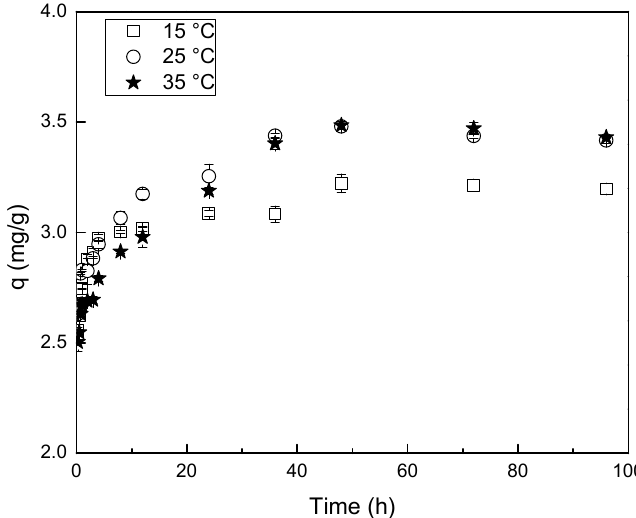
Figure 9. Impact of temperature and contact time on adsorption of RB5 on UBC.